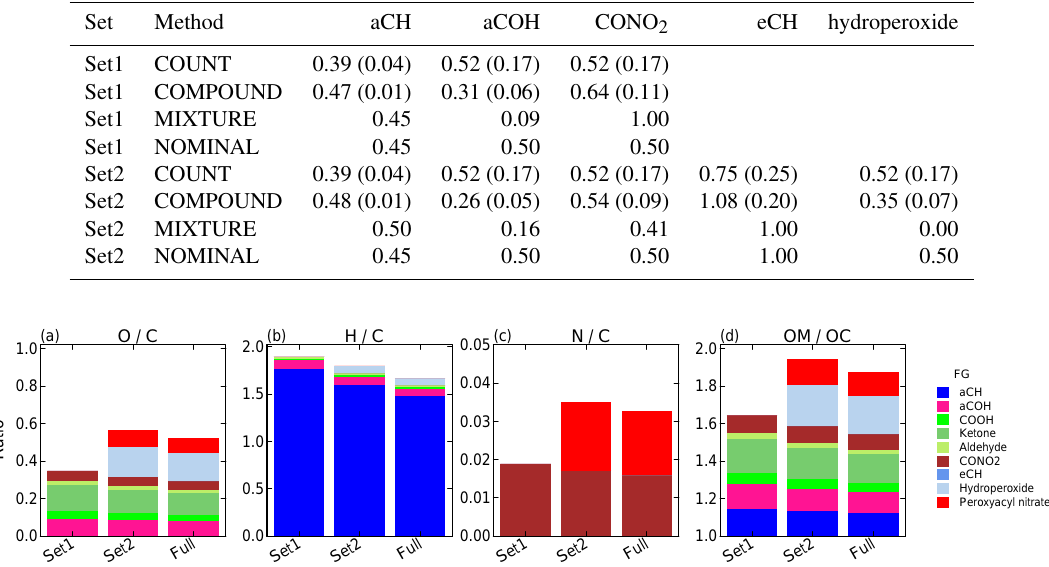
) shown in panels (a) – (c) are in molar units, and OM / OC C